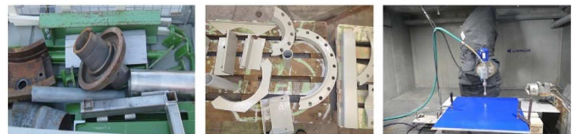
Fig. 2. Left: component sample from the dismantling. Middle: parts with a newly applied, resistant coating for removal tests. Right: experimental setup for determining the jet parameters of various nozzle tools.